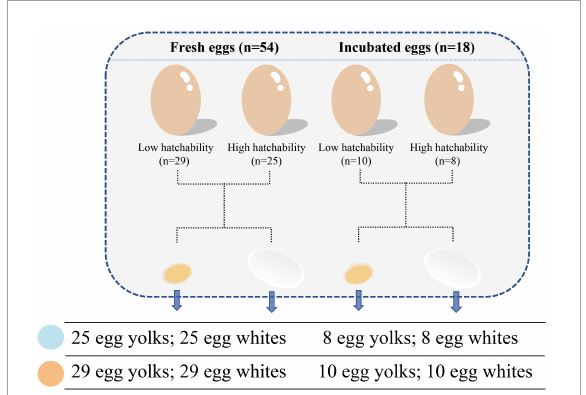
FIGURE1 Scheme of sample collection including egg compartment, incubation, and